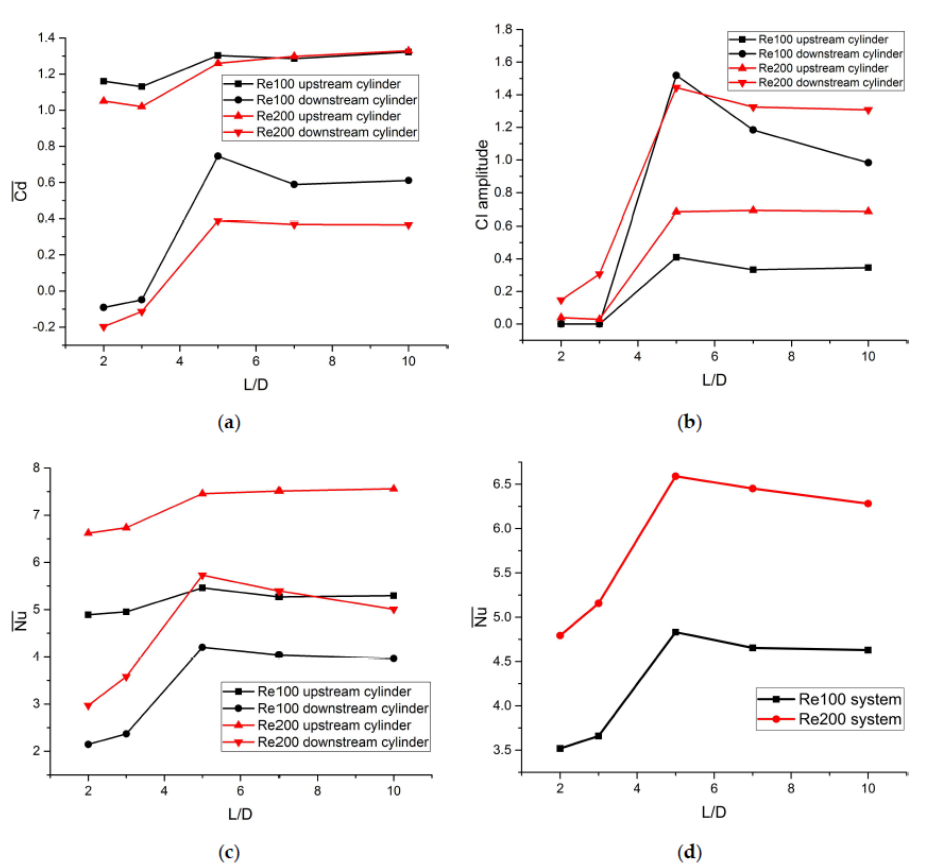
Figure 13. Effect of distance ratio on the time mean hydrodynamic forces and Nusselt number at Re = 100 and Re = 200: ( a ) drag; ( b ) amplitude of lift; ( c ) Nusselt number of each cylinder; ( d ) Nusselt number of the array system.